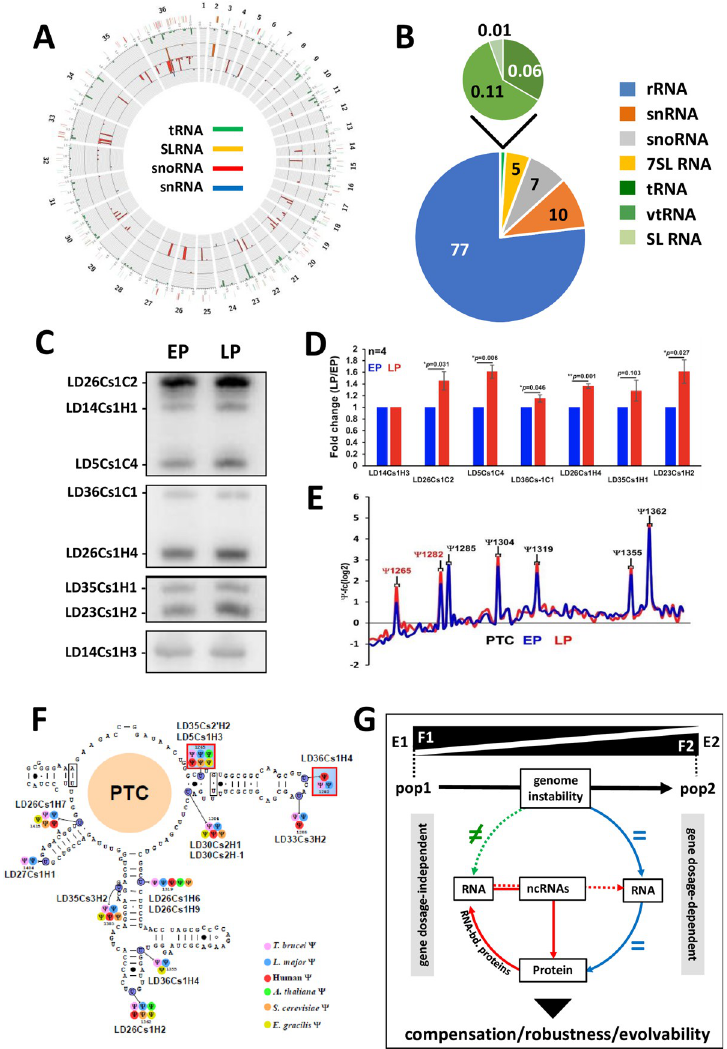
Fig 5. The fitness tradeoff in LP promastigotes correlates with snoRNA expression changes and increased rRNA pseudouridinylation levels. (A) Genomic map of L . donovani Ld1S ncRNA genes. (B) Composition of the small RNome identified in EP parasites. (C) Northern blot analysis of selected snoRNAs, Ld14Cs1H3 was used as loading control. Two representative northern blots out of four are presented. The analyses were performed with two independent cultures derived from the same frozen stock (see S10 Fig for details). (D) Histogram plot representing the fold changes between LP (red bars) and EP (blue bars) log parasites corresponding to densitometric analysis of the signals shown in (C). Data are presented as mean ± S.E.M. Student’s t-test was performed to determine the p-value. � p-value < 0.05; �� p-value < 0.005. (E) Line graph of the fold change in rRNA pseudouridinylation level ( C -fc, log2) in EP (blue line) and LP parasites (red line). The shown result is representative of three independent cultures derived from the same frozen stock (see S10 Fig for details). Positions where the C level is increased in all three replicates are indicated in red. (F) The location of C sites in the rRNA is depicted on the secondary structure. Hypermodified sites are highlighted in red squares. The snoRNAs guiding each C are indicated. The color code for each C site is indicative of the organism where it was already reported. (G) Model of Leishmania evolutionary adaptation. Different environments (E1, E2) select for different fitness traits (F1, F2), which modify the parasite population structure (pop 1, pop 2). In the absence of transcriptional regulation, Leishmania exploits genome instability to generate changes in gene dosage via chromosome and gene copy number variations. These changes are either correlated (blue arrows) or not (green arrow) to changes in transcript and protein abundance. The gene dosage-regulated transcriptome and proteome (right panel) is highly enriched for the GO term ‘post-transcriptional regulation of gene expression’ and thus likely regulates gene dosage-independent changes in RNA abundance (red arrow, left panel). The enrichment of these transcripts in ncRNAs in turn can control RNA stability and translatability by guiding modifications of mRNA or rRNAs. This allows for (i) compensation of deleterious gene dosage effects, (ii) phenotypic robustness despite genetic heterogeneity, and (iii) maintenance of evolvability despite selection pressure.